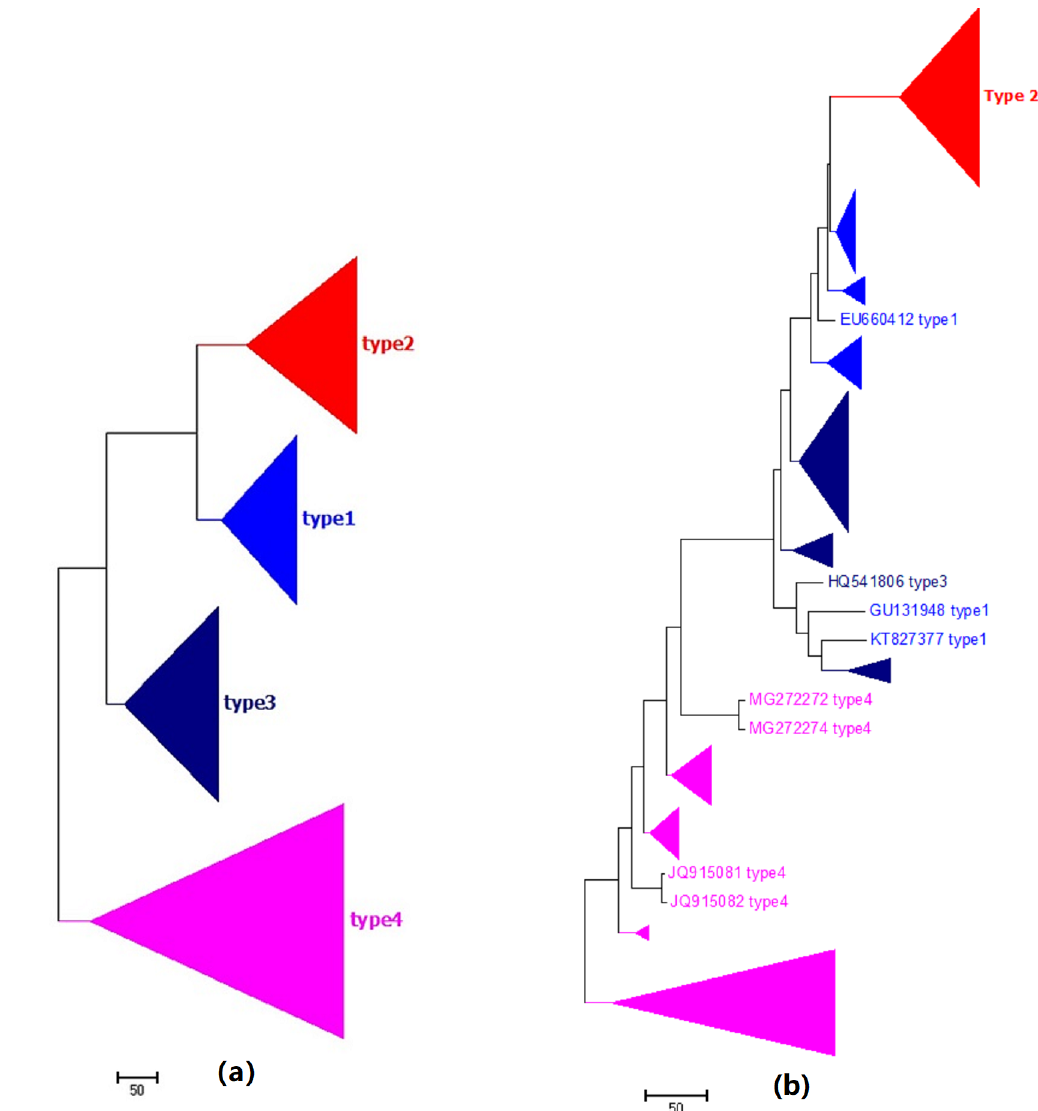
Figure 3. ( a ) The Neighbor-Joining phylogenetic tree of 330 dengue viruses genome sequences based on PCNV method. ( b ) The Neighbor-Joining phylogenetic tree of 330 dengue viruses genome sequences based on NV